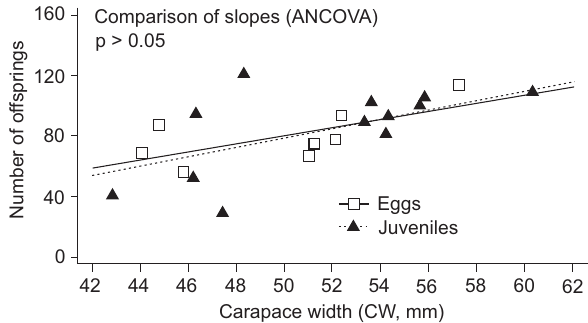
Figure 1. Number of eggs and attached juveniles in the freshwater crab Kingsleya ytupora from the Amazon region (Brazil), with a comparison of slopes (ANCOVA).